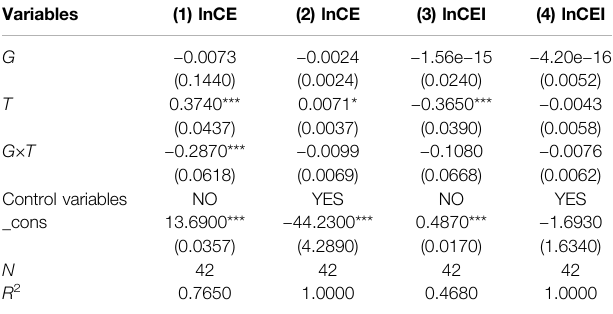
TABLE 6 | Robustness test